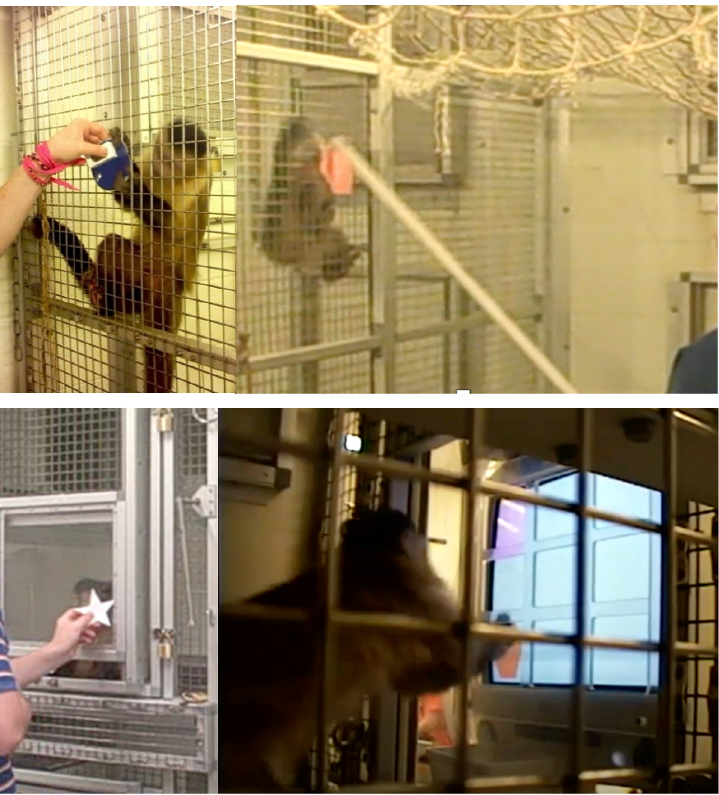
Figure 5. Capuchins completing the target behavior through mesh ( top left ), using the pole target ( top right ), across the Plexiglas TM ( bottom left ), and on the touch screen ( bottom right ). 2.8.1. Phase 2—Stage 5: Response Generalization to Differently Sized Targets Presented Behind Mesh or Plexiglas